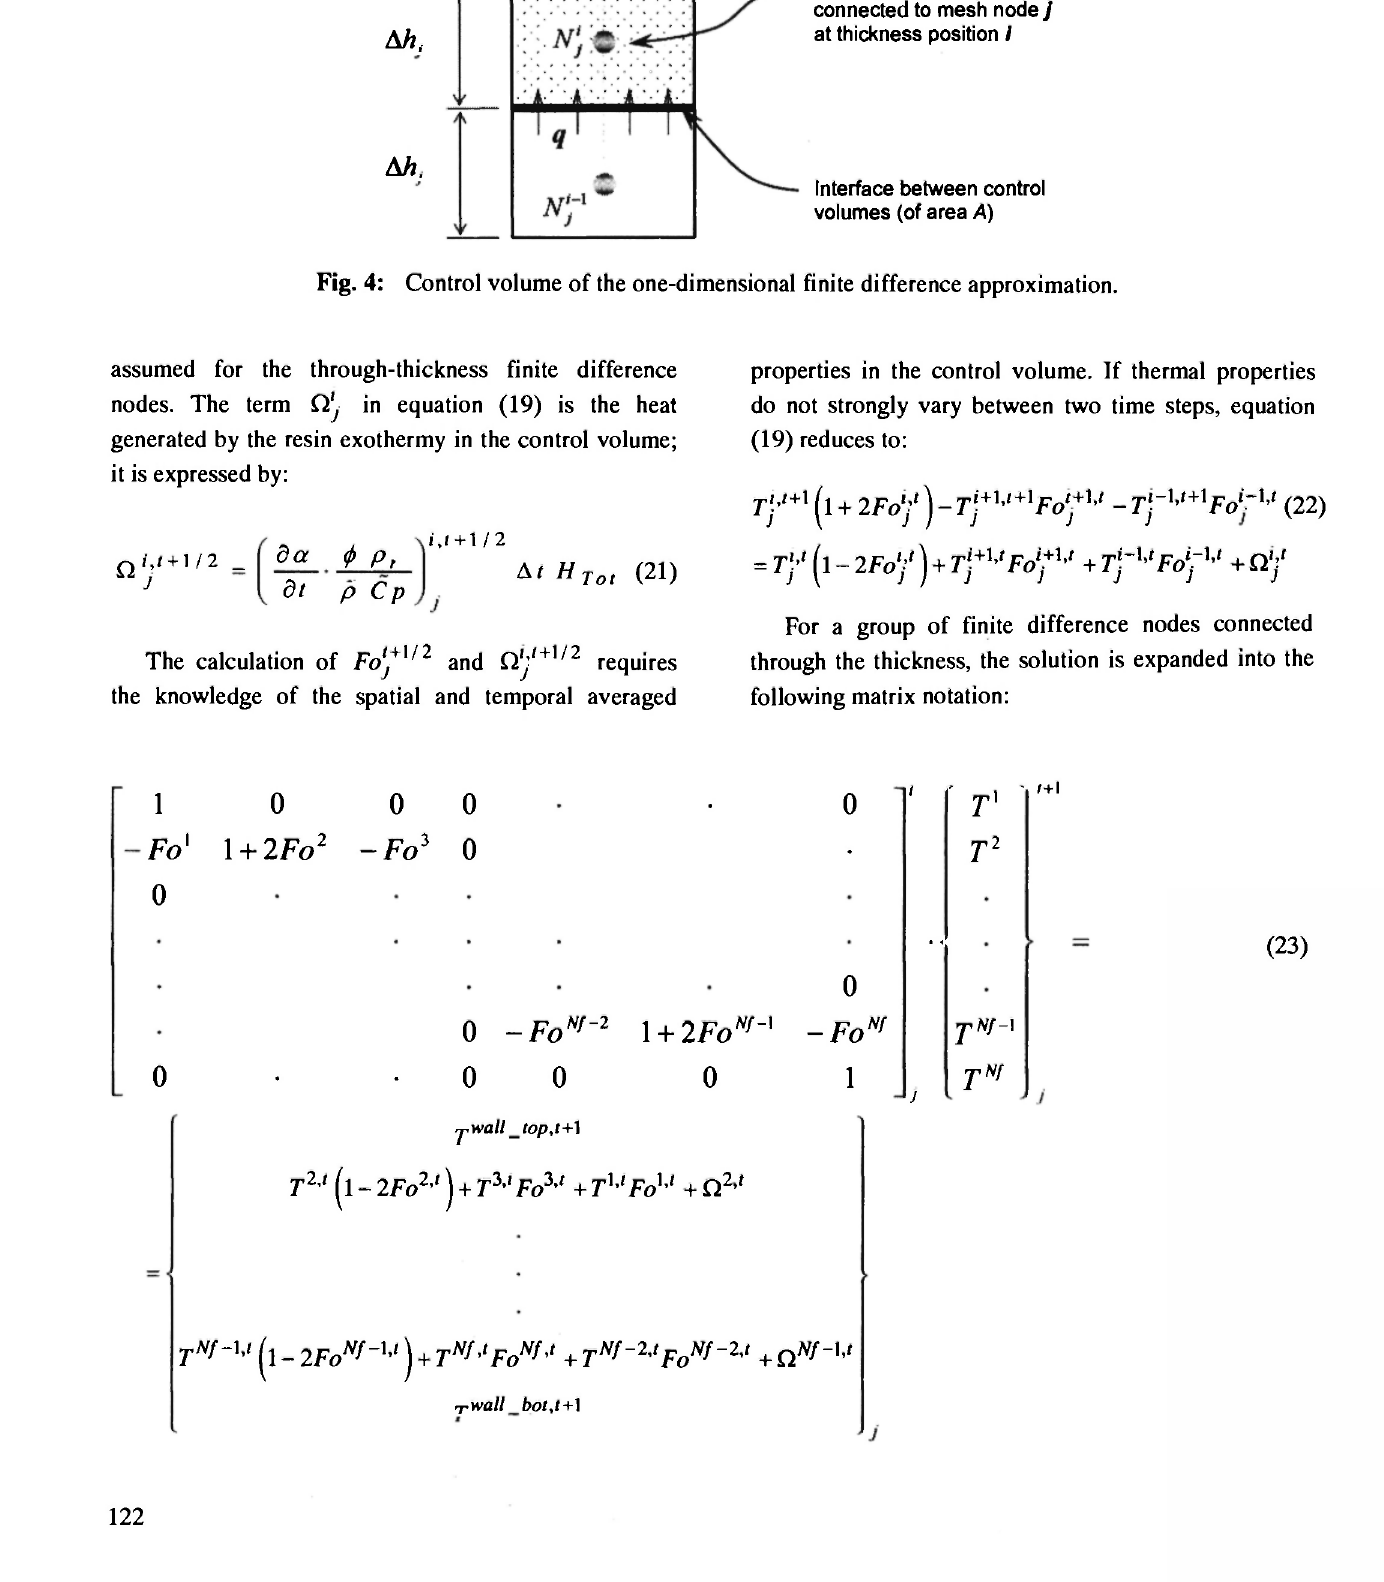
Fig. 4: Control volume of the one-dimensional finite difference